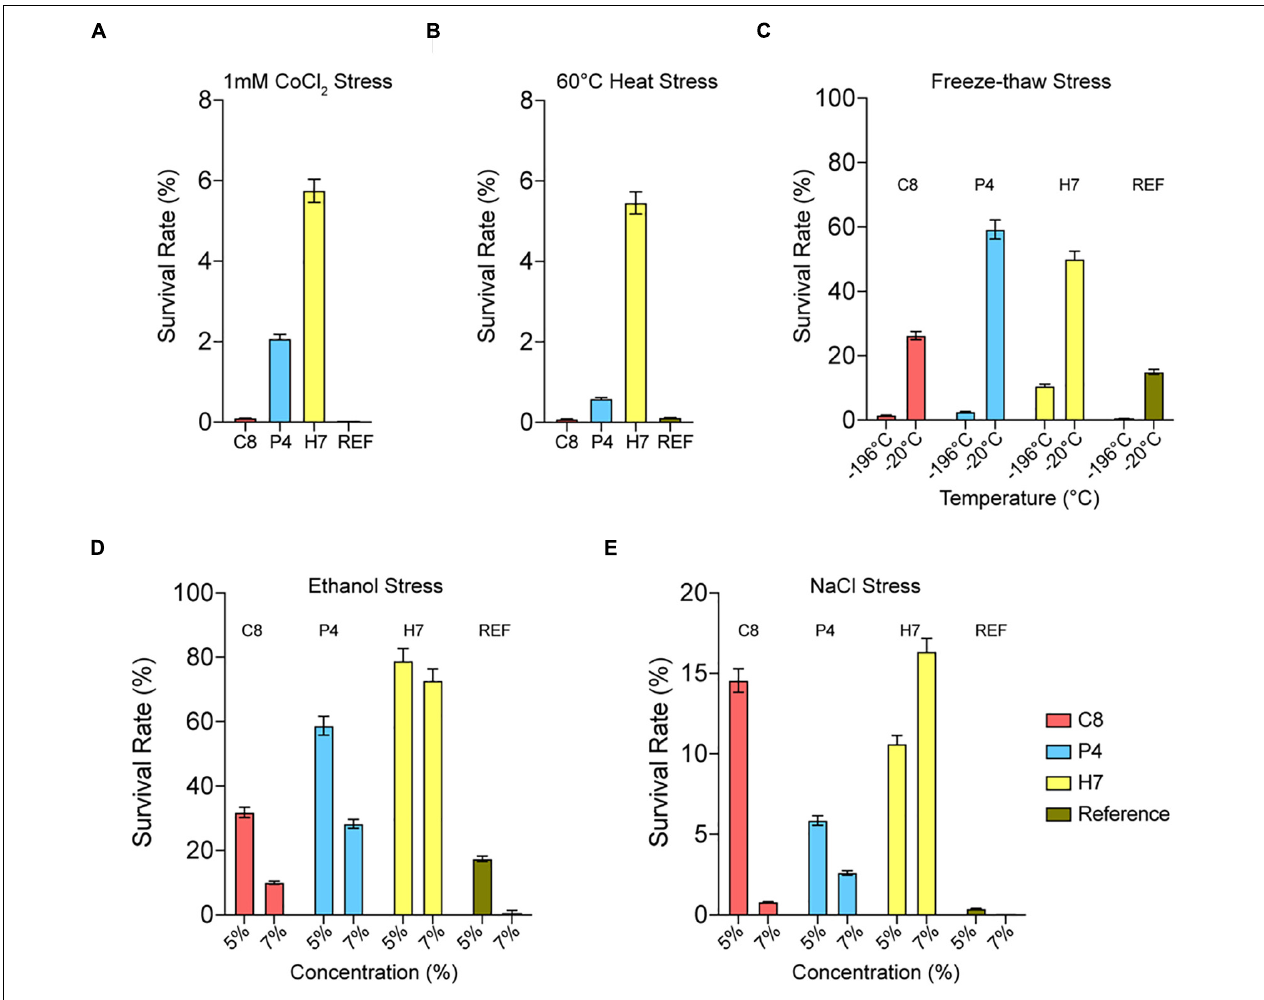
FIGURE 3 | Quantitative cross-resistance analysis (MPN) results of the highest oxidative-stress resistant strains C8, P4, H7 and the reference strain. The cultures were exposed to (A) 1 mM CoCl 2 , (B) 60 ◦ C for 10 min, (C) –196 ◦ C (liquid nitrogen) and –20 ◦ C for 25 min, (D) 5 and 7% (v/v) ethanol and (E) 5 and 7% (w/v) NaCl. The survival rates (%) were determined upon incubation (72 h, 30 ◦ C). The results were obtained using the MPN analysis under various stress